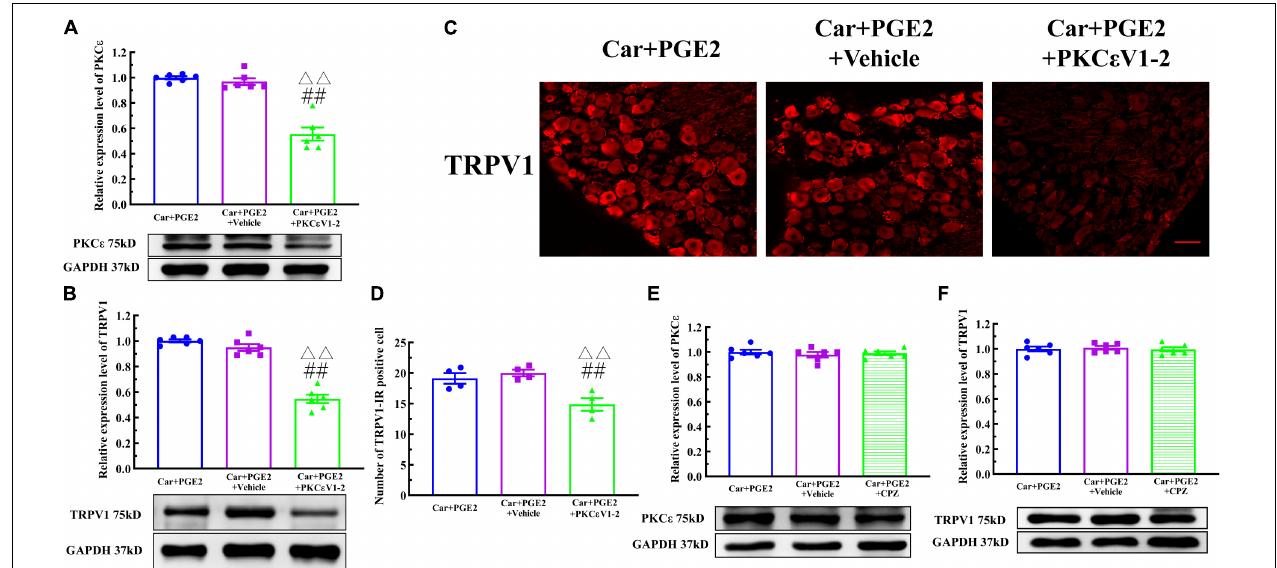
FIGURE 4 | Protein kinase C epsilon (PKC ε ) regulates TRPV1 expression in the DRG. (A) The quantification of the Western blot results and a representative Western blot showing inhibited PKC ε protein isolated from the DRG 48 h after PGE2 injection. (B) The quantification of the Western blot results and a representative Western blot showing decreased TRPV1 protein isolated from the DRG 48 h after PGE2 injection. (C) TRPV1 staining in the peripheral nervous system 48 h after PGE2 injection. Scale bar 100 µ m. (D) The quantification of TRPV1–IR positive neurons. (E) The quantification of the Western blot results and a representative Western blot showing PKC ε protein isolated from the DRG 4 h after PGE2 injection. (F) The quantification of the Western blot results and a representative Western blot showing TRPV1 protein isolated from DRG 48 h after PGE2 injection. (cid:52)(cid:52) Compared with the NS+PGE2 group, P < 0.01; ## compared with the Car+PGE2 group, P < 0.01.